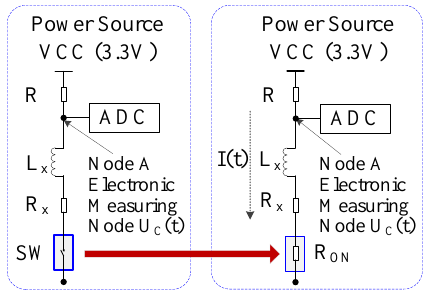
Figure 2. Theoretical IPS measurement circuit in simulation (the resistance R ON caused by the actual switching (SW) operation is